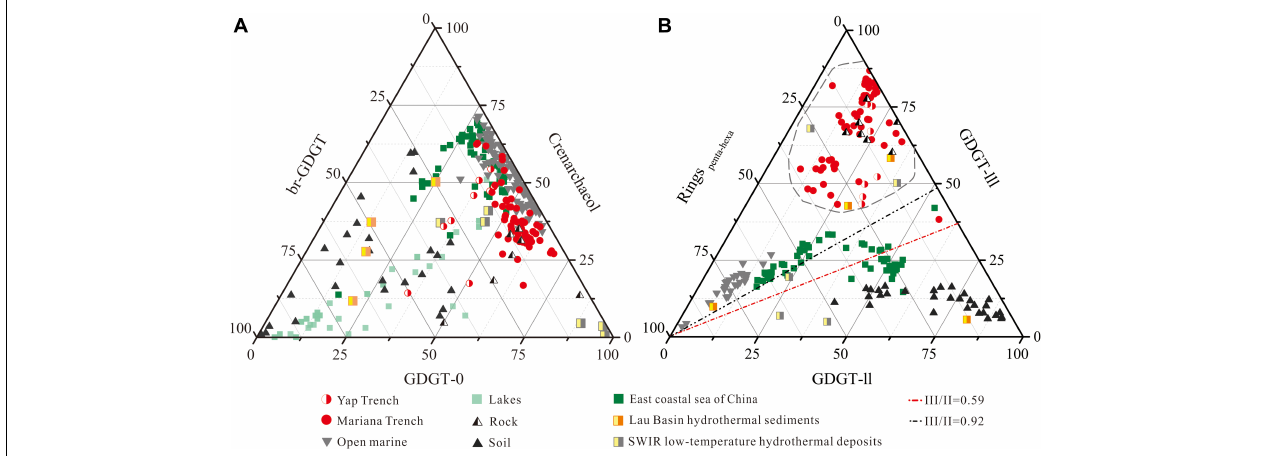
FIGURE 5 | Ternary diagram revealing the source of the GDGTs in the trench sediment. (A) GDGT-0, Crenarchaeol and sum of BrGDGTs; (B) GDGT-II, GDGT-III and rings of penta-hexa. In this figure, III/II refers to the ratio between GDGT-IIIa and GDGT-IIa (Xiao et al., 2016), whereas rings penta − hexa is the sum of the abundances of ring-shaped GDGT-II and GDGT-III. Br-GDGT refers to bacterial branched GDGT. The sources of data used in this Figure are as follows: open marine data containing particles and surface sediments from NW Pacific (Yamamoto et al., 2016) and surface sediments from SE Pacific (Kaiser et al., 2015); lake data containing particulates and surface sediments from 47 European lakes (Blaga et al., 2009); coastal sediment data containing surface sediments from Gulf of Lions (Kim et al., 2010) and the east coastal sea of China (Lü et al., 2014); soil data containing soil samples from 6 provinces in eastern China (Wu, 2014); data on hydrothermal sediments (Hu et al., 2012); data on low-temperature hydrothermal deposits (Pan et al., 2016). For structures see Supplementary Figure 1